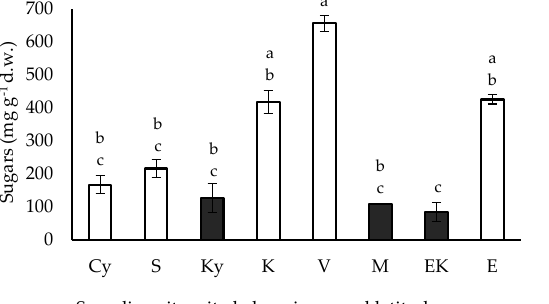
Figure 3. Soluble sugar content in the fruit pericarp of C. spinosa harvested from inland (closed bars) and coastal habitats (open bars), cited along increased latitude. The values are means ± standard deviation; significant difference ( p < 0.05) was detected using Kruskall–Wallis’ test and is marked using lowercase letters, according to post hoc analysis.